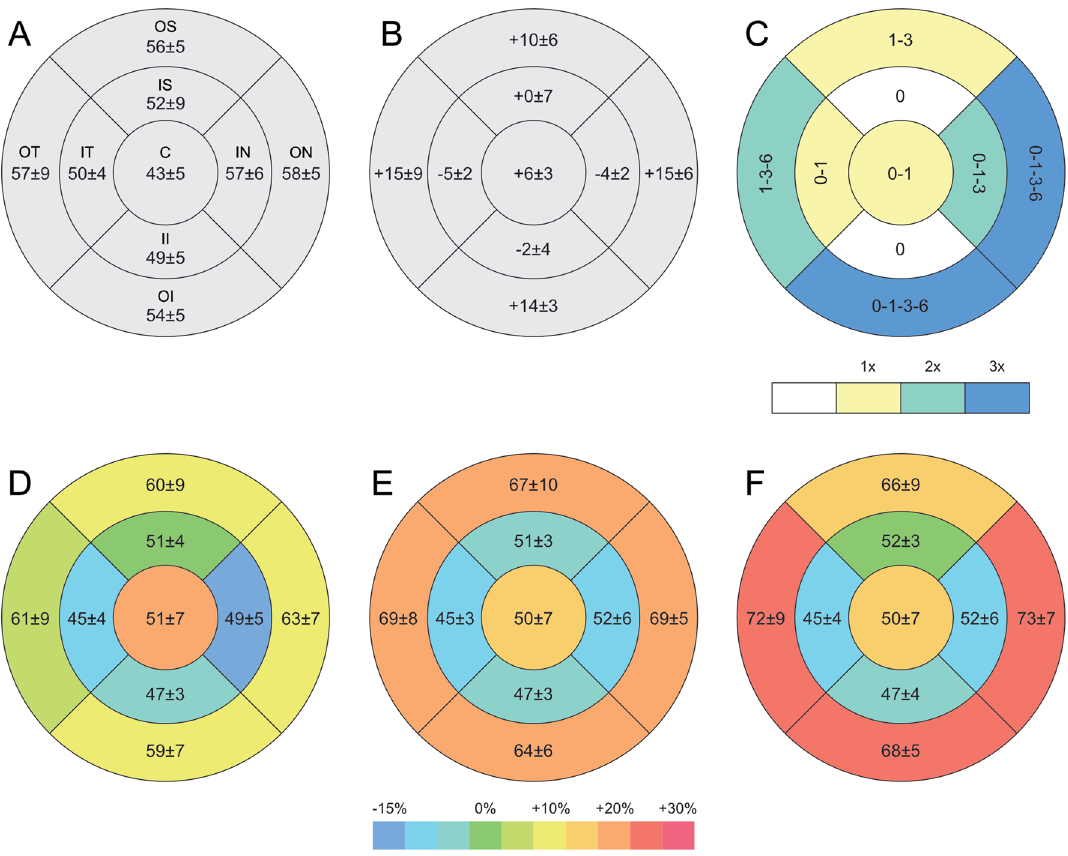
Figure 2. Epithelial thickness profile map with mean preoperative absolute values ± SD ( A ) and 6-month differences ( B ). Statistical significance changes of each sub-field and relative reference periods are reported in C with color-coding representing number of significant variations observed during the follow-up (white: no changes; 1×: change once; 2×: change at two time points; 3×: change at each time point). Mean value ± SD at 1 month ( D ), 3 months ( E ) and 6 months ( F ) are reported with color-coding representing percentage change from baseline ( C central, OS outer-superior, IS inner-superior, OT outer-temporal, IT inner-temporal, IN inner- nasal, ON outer-nasal, II inner-inferior, OI